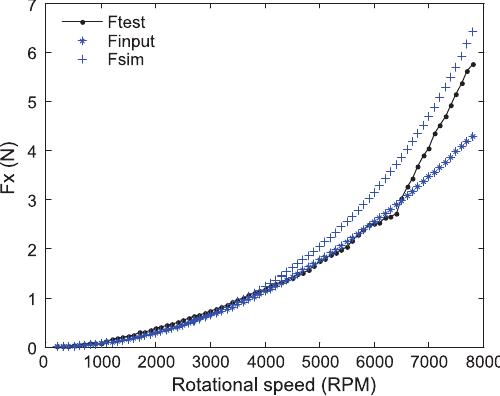
Fig. 6. Force comparison obtained by simulation and